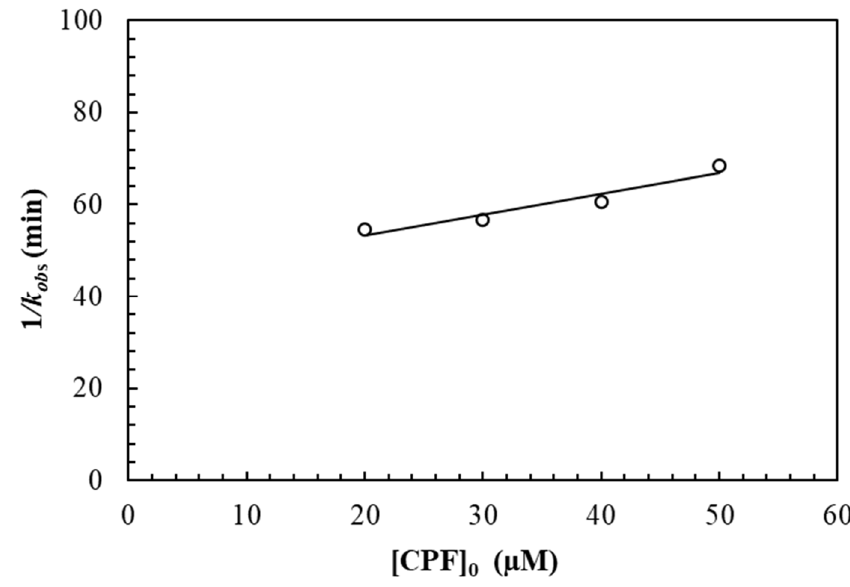
Figure 12. Plot of 1/ k obs vs. initial concentration of CPF.